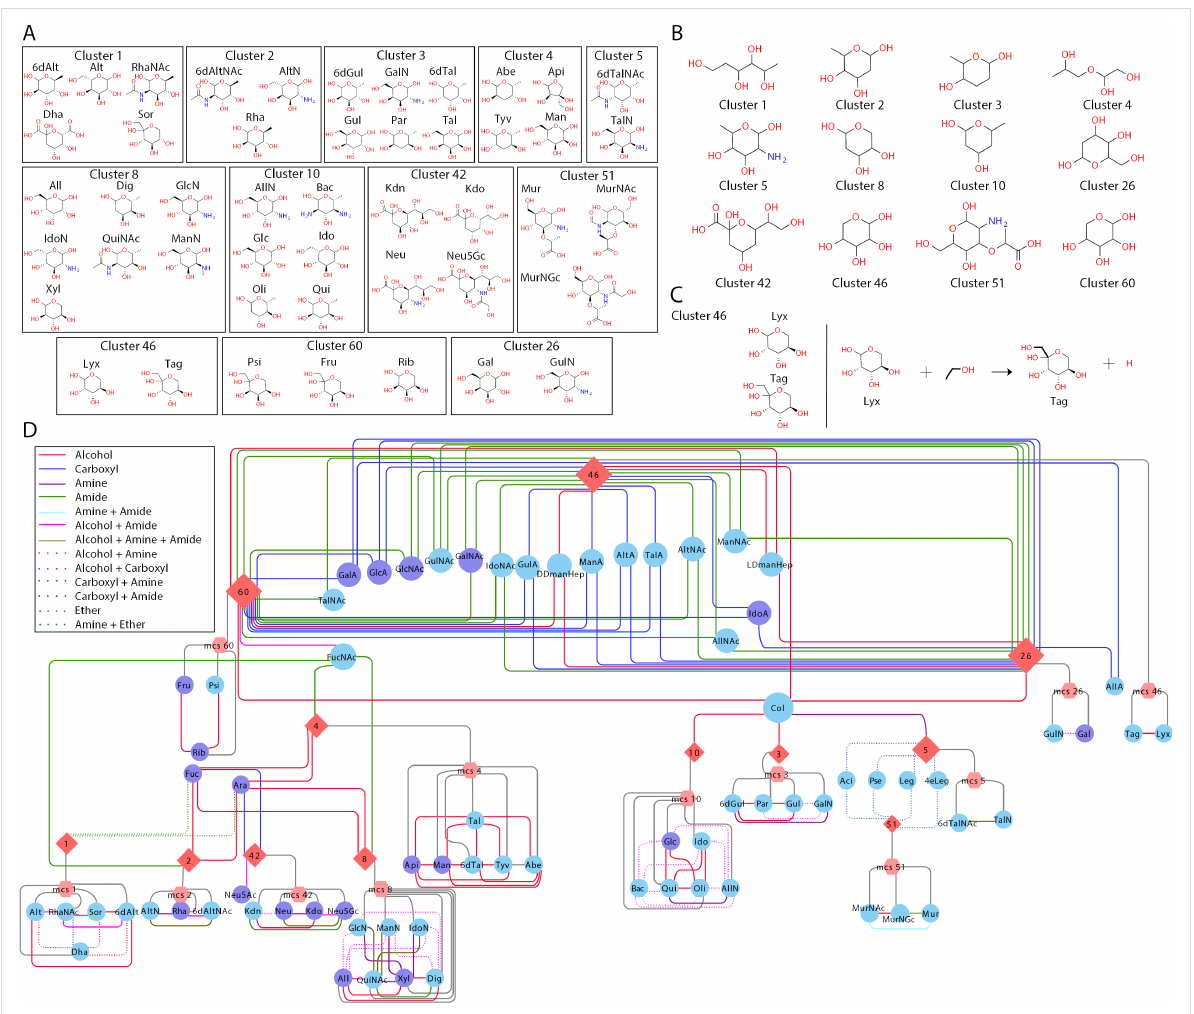
Figure 2: Monosaccharide reachability analysis. (A) Clusters contain monosaccharides with highly similar stereochemistry (>80%). (B) The maximum common substructure (MCS) associated with each cluster. (C) An example to illustrate the modifications needed to reach one monosaccharide to another, as identified by the complete monosaccharide reachability network (Table S6, Supporting Information File 1). (D) The monosaccharides reachability network, showing only connectivity for the least number of modifications needed, differentiated by color as stated in the legend, between monosaccharides (circle) and clusters (diamond). Additionally, the node size denotes the number of different possible paths taken for them to be reached. Please note that each edge is not a predicted or proposed feasible reaction. Edges denote functional groups that can be added or removed from one monosaccharide to represent